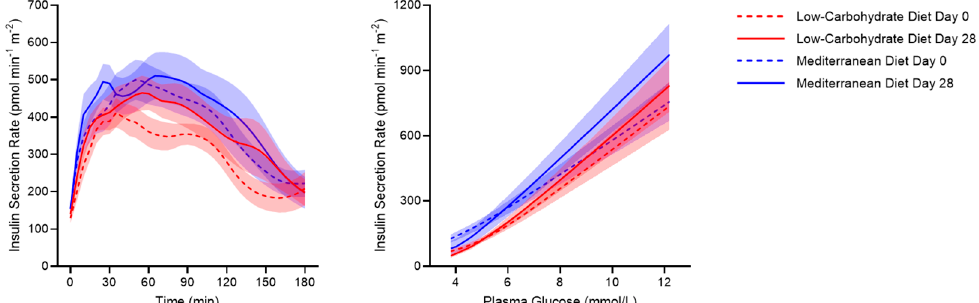
Figure 2. Insulin secretion rate during a 75-g OGTT ( left panel) and insulin secretion rate against plasma glucose levels ( right panel) in morbidly obese individuals before (dotted lines) and after (continuous lines) a 4-week low-carbohydrate diet (red lines) or Mediterranean diet (blue lines). Thick lines indicate mean and shaded areas indicate SEM.